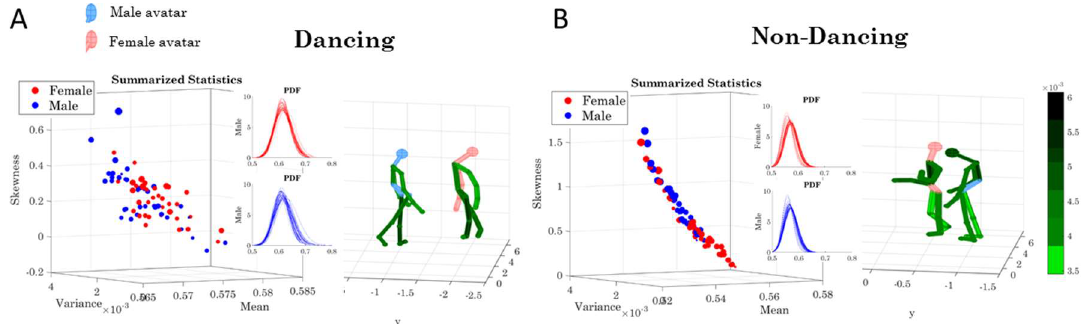
Figure 15. Bodily maps of noise (scale values) for the female and male using the bending profiles pooled across all routines for each body node. ( A ) Dancing condition with insets showing estimated PDFs for female and male. Avatars color-coded for one frame with levels of noise for the physically entrained body parts as explained in Figure 8 (blue avatar male, red avatar female, and green color gradient as in color bar in ( B ), also showing the non-dancing condition).